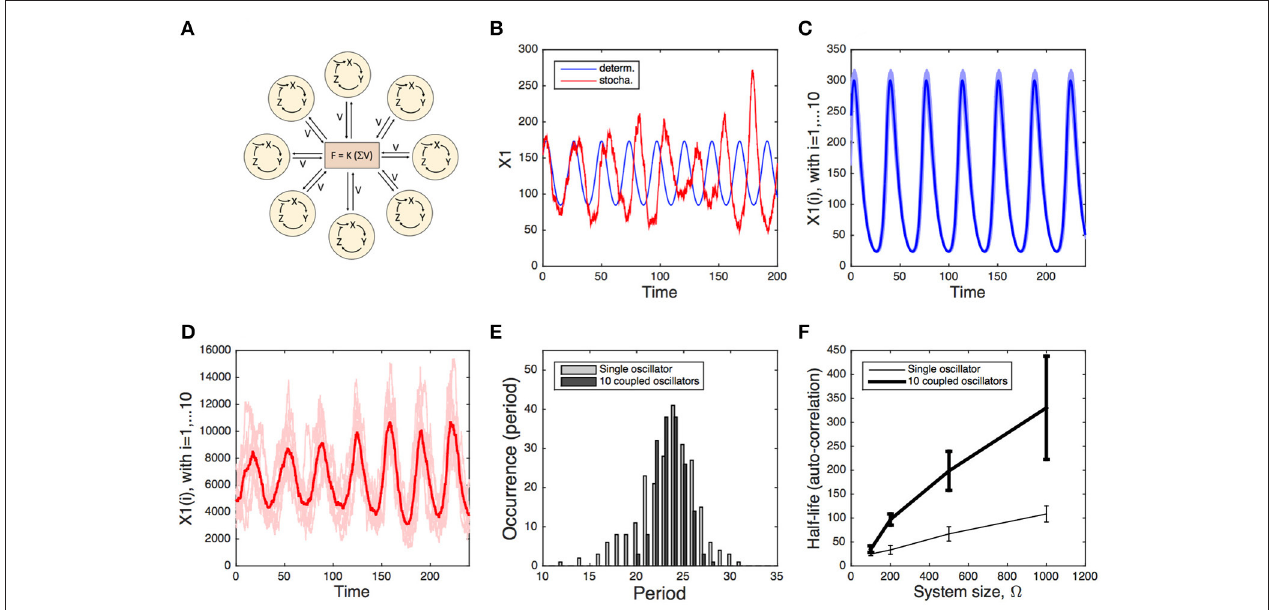
FIGURE 1 | Deterministic vs. stochastic simulation of a system of coupled circadian oscillators. (A) Scheme of the model. Each oscillator is modeled by a 3-variable Goodwin-like model. The oscillators are coupled through the mean field obtained by the average concentration of the clock-controlled release of a neurotransmitter (see Gonze et al., 2005 for the description and deterministic analysis of the model). (B) Deterministic (blue) and stochastic (red) oscillations of the single-oscillator model. (C) Deterministic oscillations of 10 coupled oscillators, displaying 10% of variability in their free-running period. (D) Stochastic oscillations of the same 10 coupled oscillators. Stochastic simulations in (B,D) have been carried out for a system size (cid:127) = 500. (E) Period distribution of the single oscillator (gray) and the 10 coupled oscillators ( (cid:127) = 500, black). (F) Half-life of the auto-correlation as a function of the system size (cid:127) , determined for the single oscillator (thin curve) and the 10 coupled oscillators (thick curve). The error bars denote the standard deviation over 10 simulations. Stochastic simulations have been performed using the Gillespie algorithm (see Supplementary Information), as described in Gonze et al. (2002) and in Gonze and Goldbeter (2006).